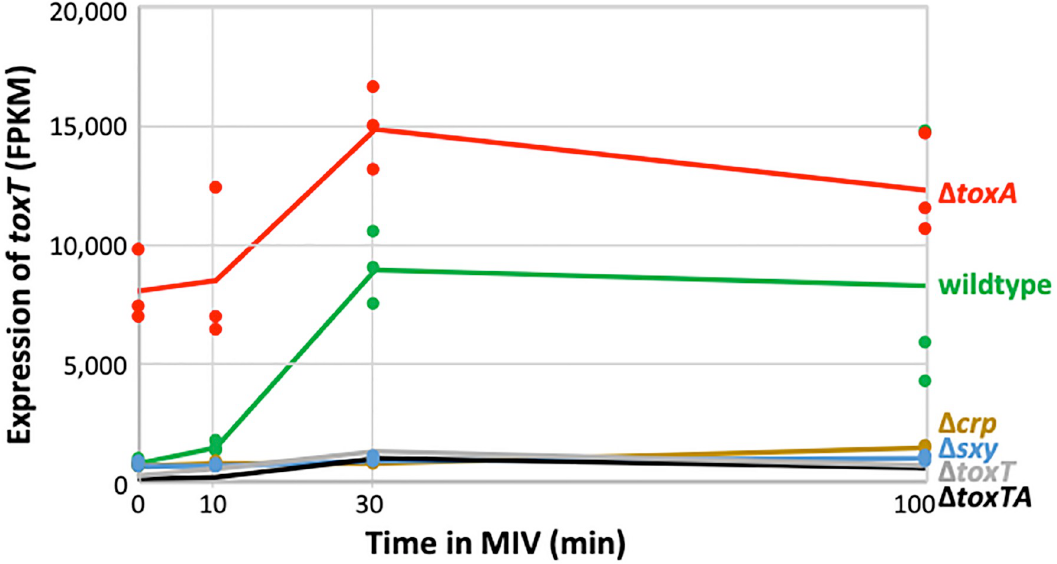
Fig 7. Competence-induced changes in transcript level of H . influenzae toxT . Sample FPKM values (dots) and means (lines) for toxT (HI0660). Strains: wildtype: green; Δ crp : brown; Δ sxy : blue; Δ toxA : red; Δ toxT : grey; Δ toxTA : black. The values for the Δ toxT and Δ toxTA samples are underestimates because most of the gene has been deleted in these